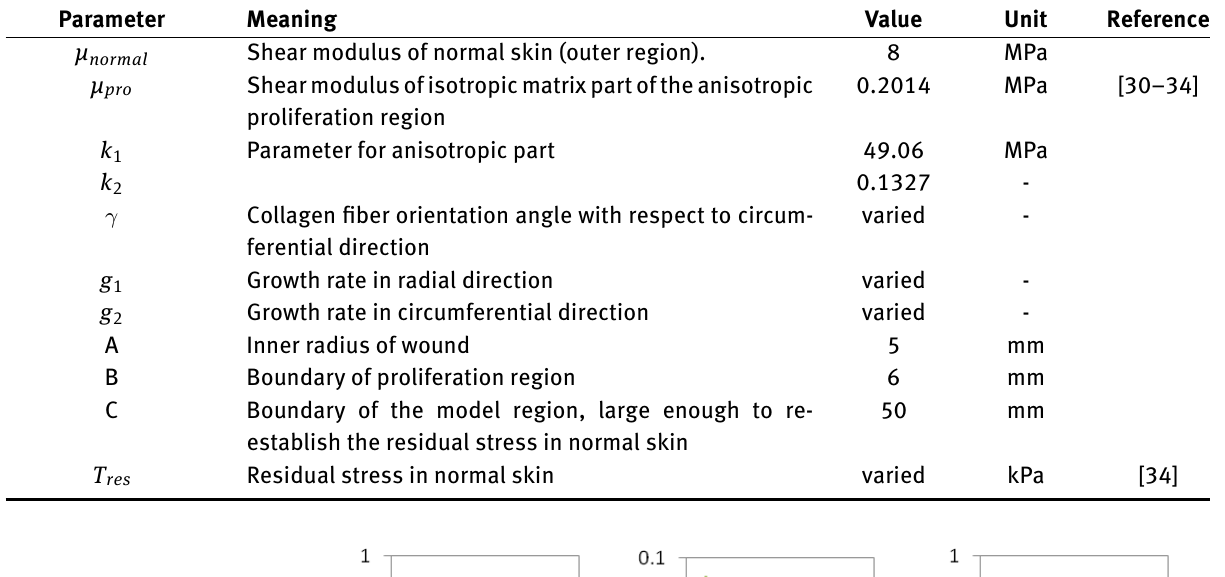
Table 2: Parameter values for wound model.